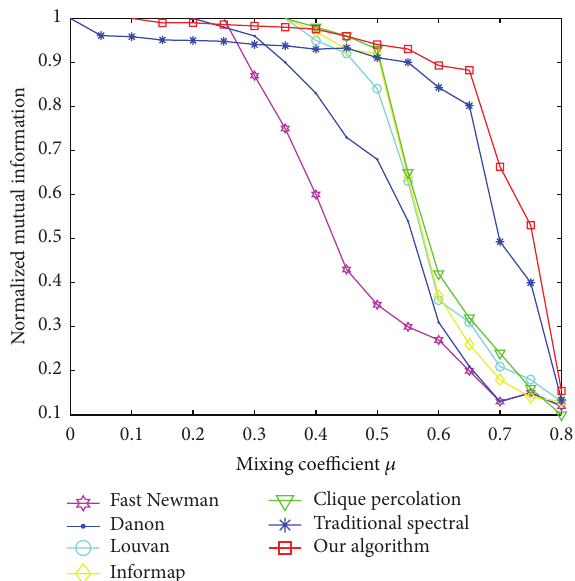
Figure 3: The NMI of the seven methods with the change of 𝜇 . out